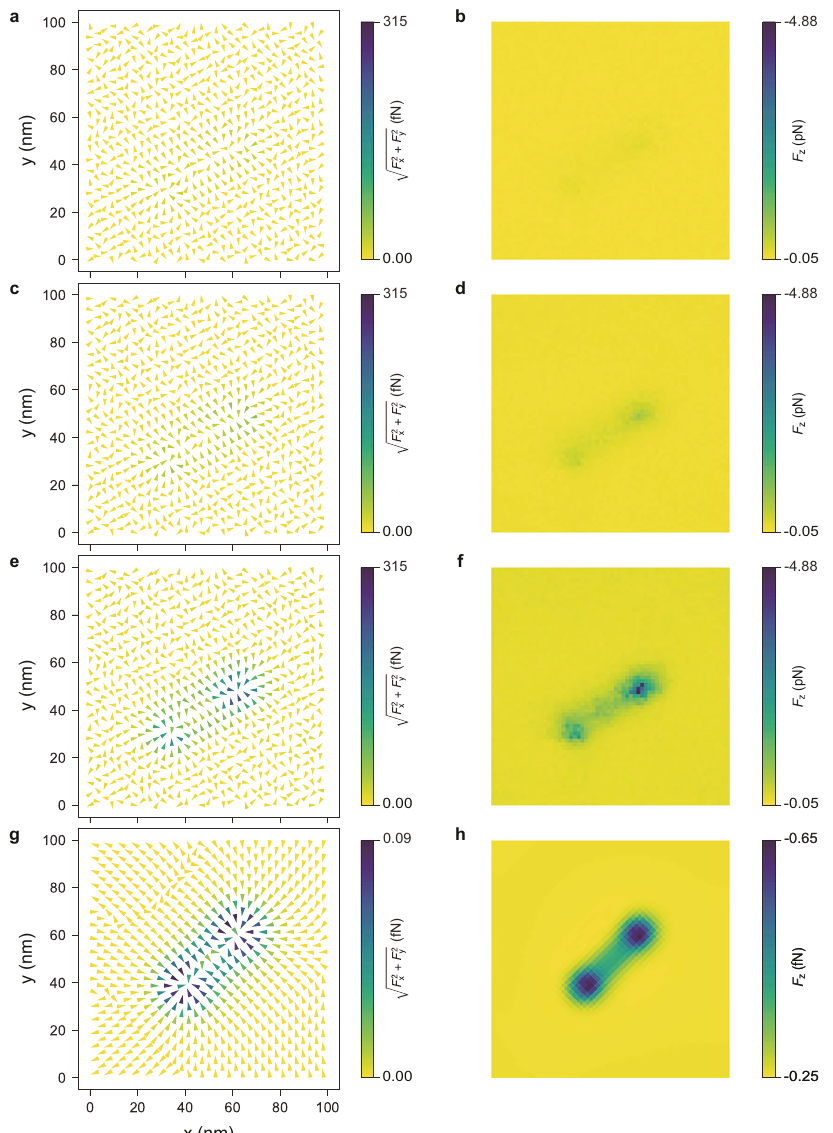
Fig. 4 Photoinduced force fi eld map using the laser with 660 nm wavelength. a , c , e Photoinduced force map directing x and y at Δ z = 2.0, 1.0, 0.0 nm. b , d , f Photoinduced force map directing z at Δ z = 2.0, 1.0, 0.0 nm. g , h Theoretically calculated photoinduced force fi eld vector mapping ( Δ z = 1.0